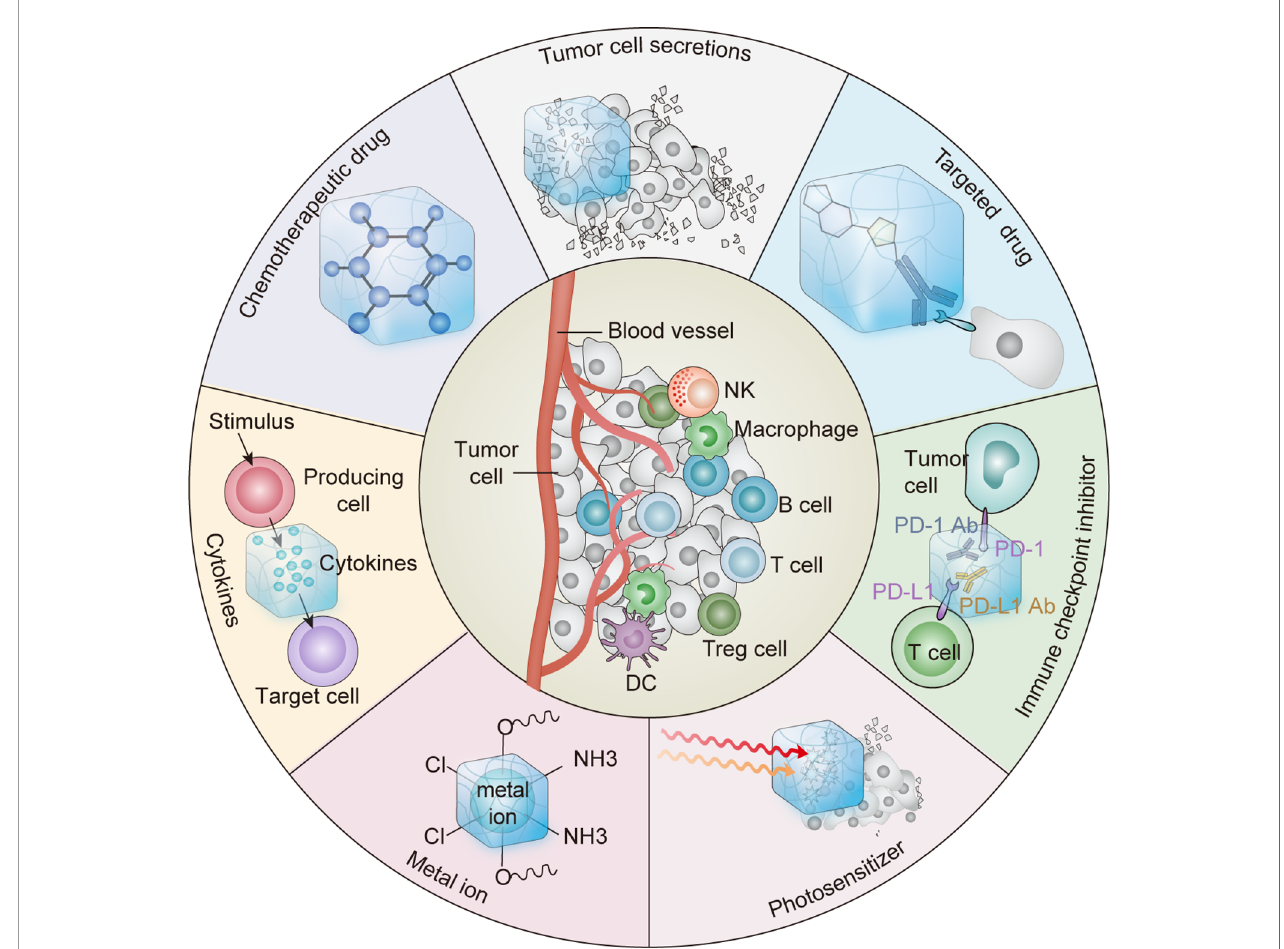
FIGURE 1 | Schematic diagram of antitumor therapy platform using hydrogels as platform to elicit antitumor immune